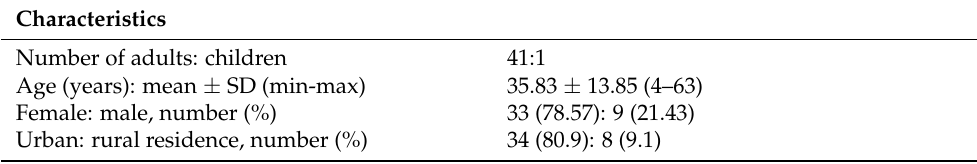
Table 1. Demographic characteristics of the studied patients.